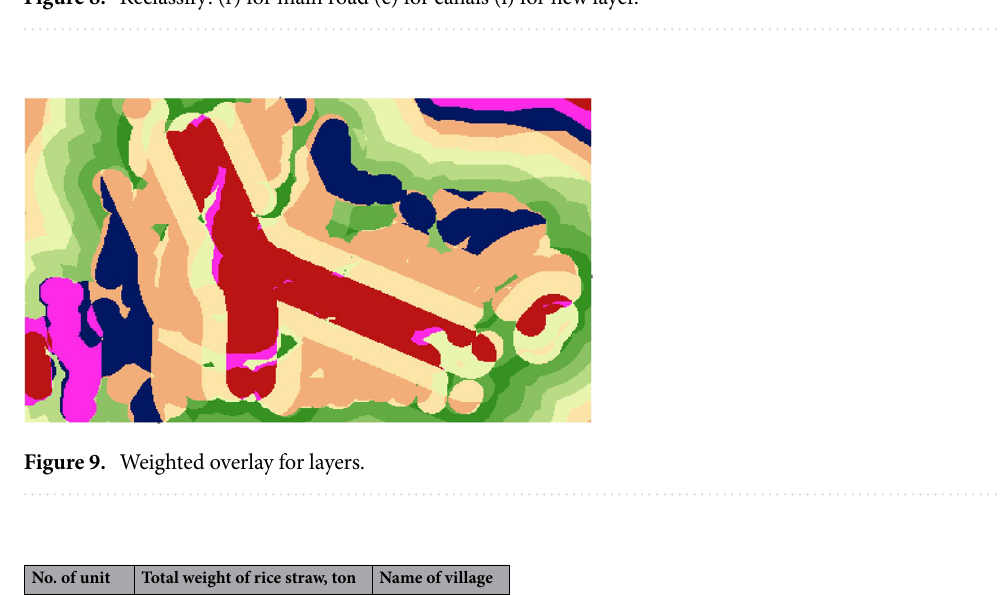
Figure 8. Reclassify: (r) for main road (c) for canals (l) for new layer.